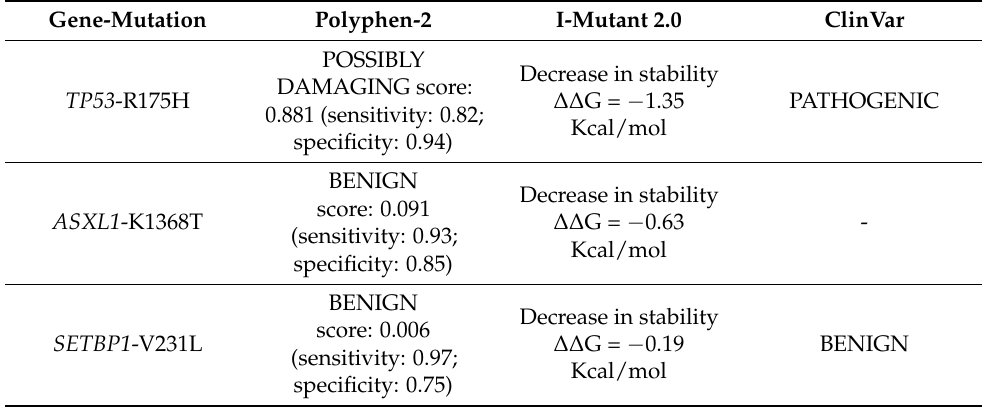
Figure 5. p53 interaction with DNA helix (orange), 3 subunits shown (colored differently), Arg175 shown in green. Table 7. Prediction of impact of mutations.